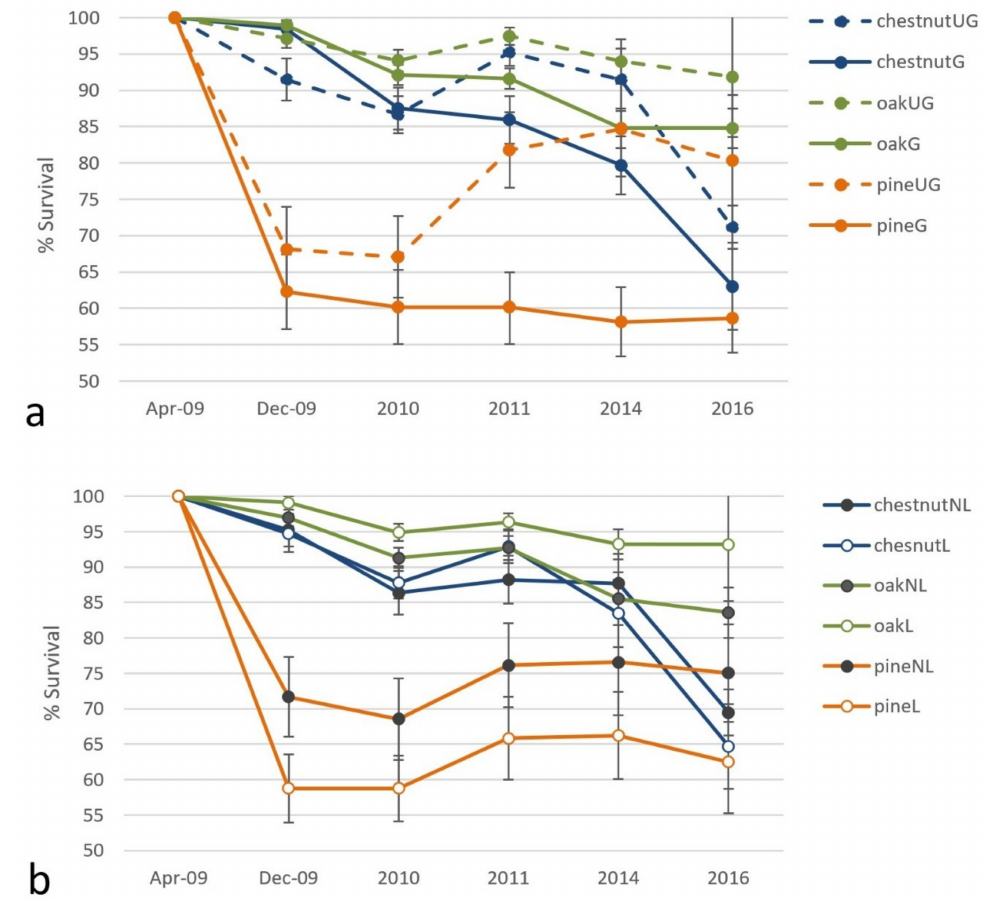
Figure 2. ( a ) Survival, by grading treatment, of shortleaf pine (orange), white oak (green) and American chestnut (blue), across years; solid lines indicate graded (G) and dashed line un-graded (UG) treatments, ( b ) Survival, by lime treatment, of shortleaf pine (orange), white oak (green) and American chestnut (blue), across years; white circles indicate lime (L) and black circles no lime (NL) treatments. Bars indicate standard